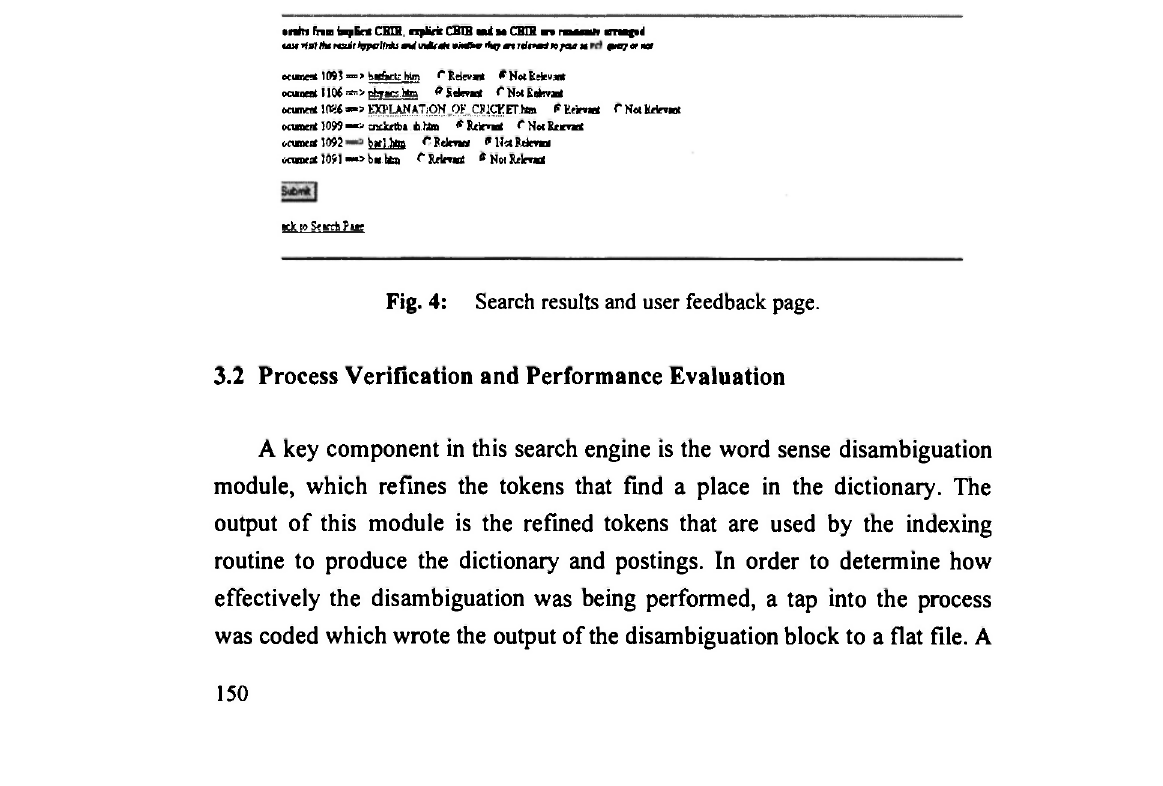
Fig. 3: User interface for explicit contextual IR.